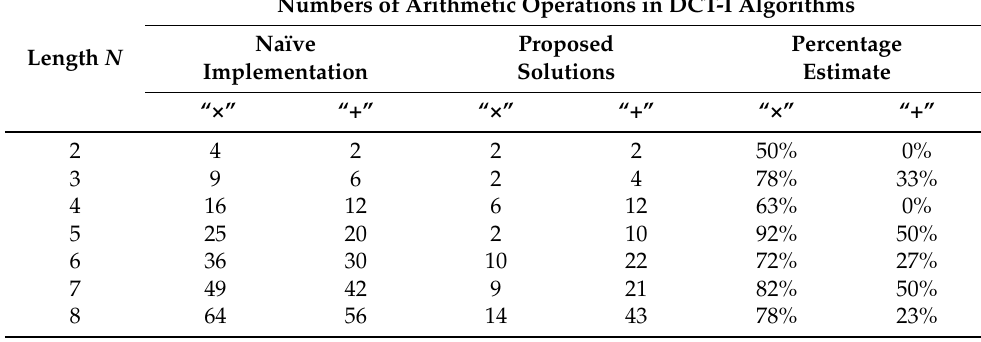
Table 1. Arithmetical complexities of naïve implementation and proposed